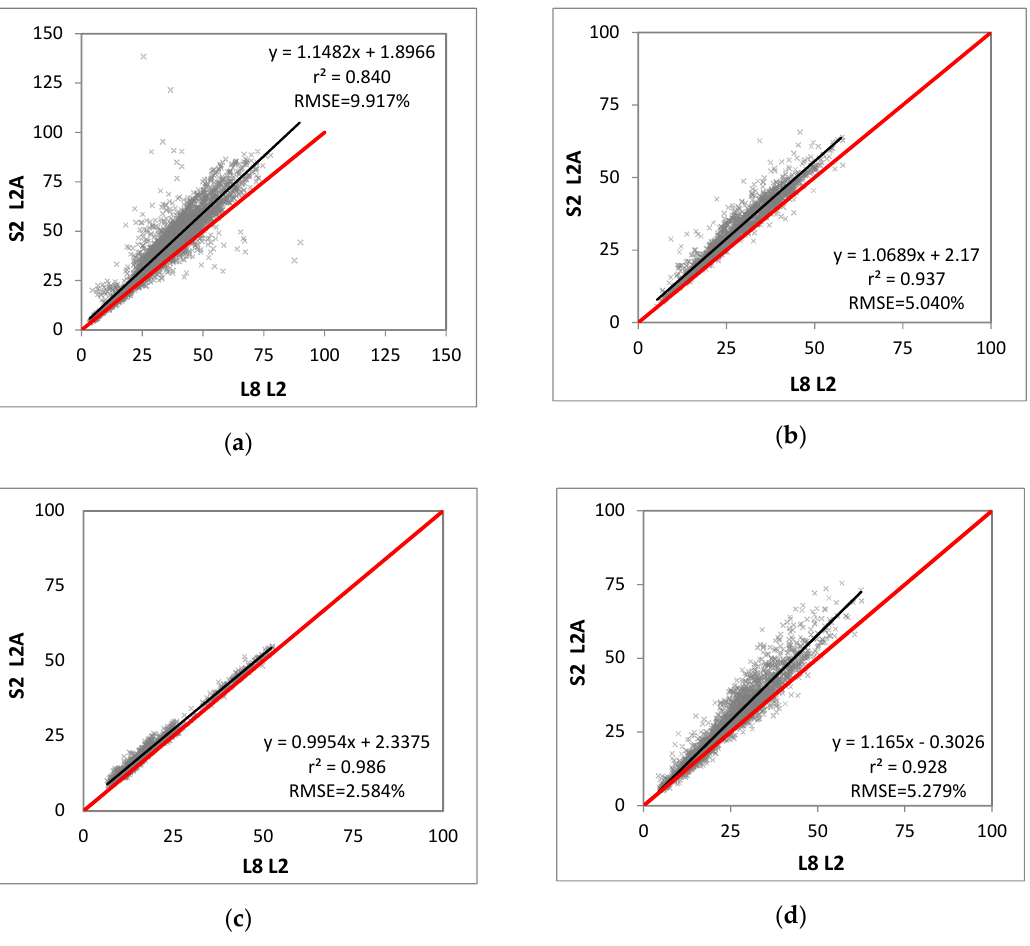
Figure 6. Correlation of all surface reflectance values between the six common bands of L8 L2 and S2 L2A products, with n being the number of total data points per study site: ( a ) SS1 ( n = 3600); ( b ) SS2 ( n = 1800); ( c ) SS3 ( n = 1200); ( d ) SS4 ( n = 3000). The black line refers to the best fitting or regression line, while the red line refers to the 1:1 line.